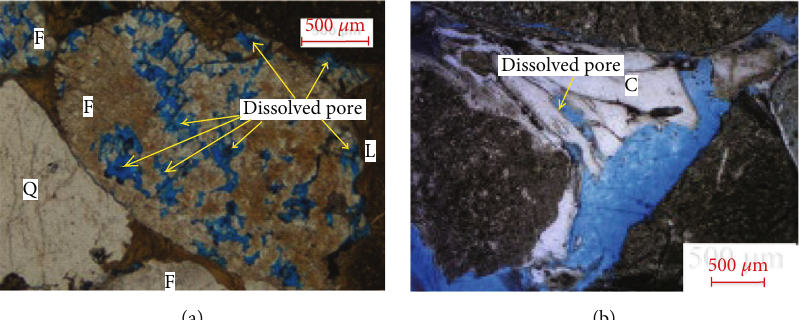
Figure 5: Microscopic characteristics of dissolution features of sandy conglomerates from Triassic Baikouquan Formation in the slope of the Mahu Sag. In the pictures, pores in blue. (a) A single feldspar has been dissolved and produced many dissolved pores and (b) the cements has been dissolved. F: feldspar; Q: quartz; L: lithics; C: